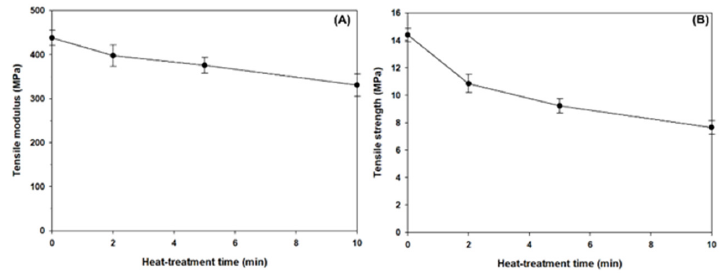
Figure 5. Variations of the tensile modulus ( A ) and strength ( B ) of henequen fibers exposed at 235 °C for different heat-treatment times, measured by a single fiber tensile test.